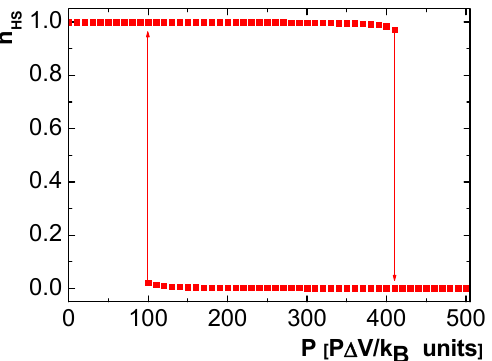
vs . P at 400 K for [Fe(Htrz) HS